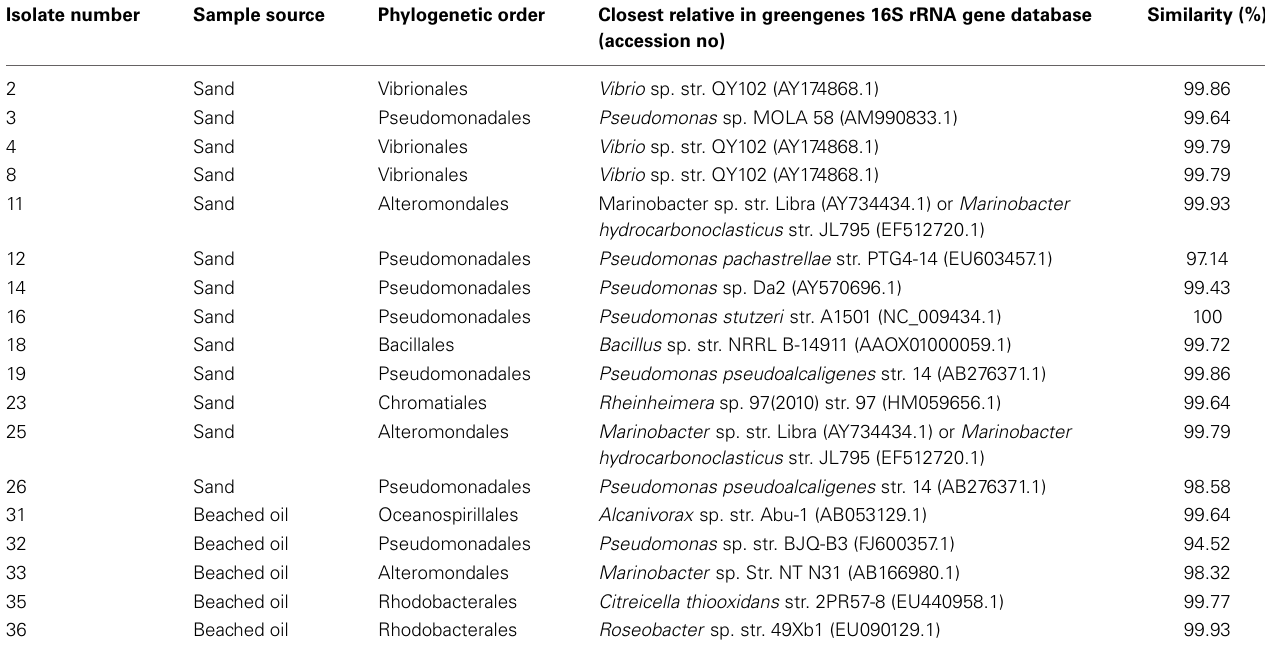
Table 2 | Cultured Isolates retrieved from beached oil and contaminated beach